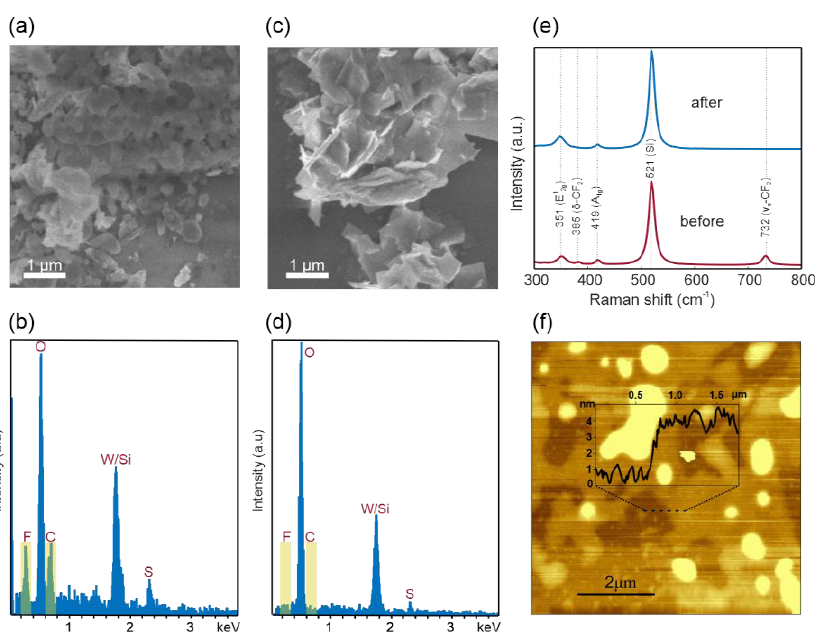
Figure 4. SEM image ( a ) and EDX spectra ( b ) of WS 2 sample before filtering; SEM image ( c ) and EDX spectra ( d ) of WS 2 sample before filtering; ( e ) Raman spectra of WS 2 samples before and after filtering ( f ) Atomic force micrograph of WS 2 flakes obtained by AAE.